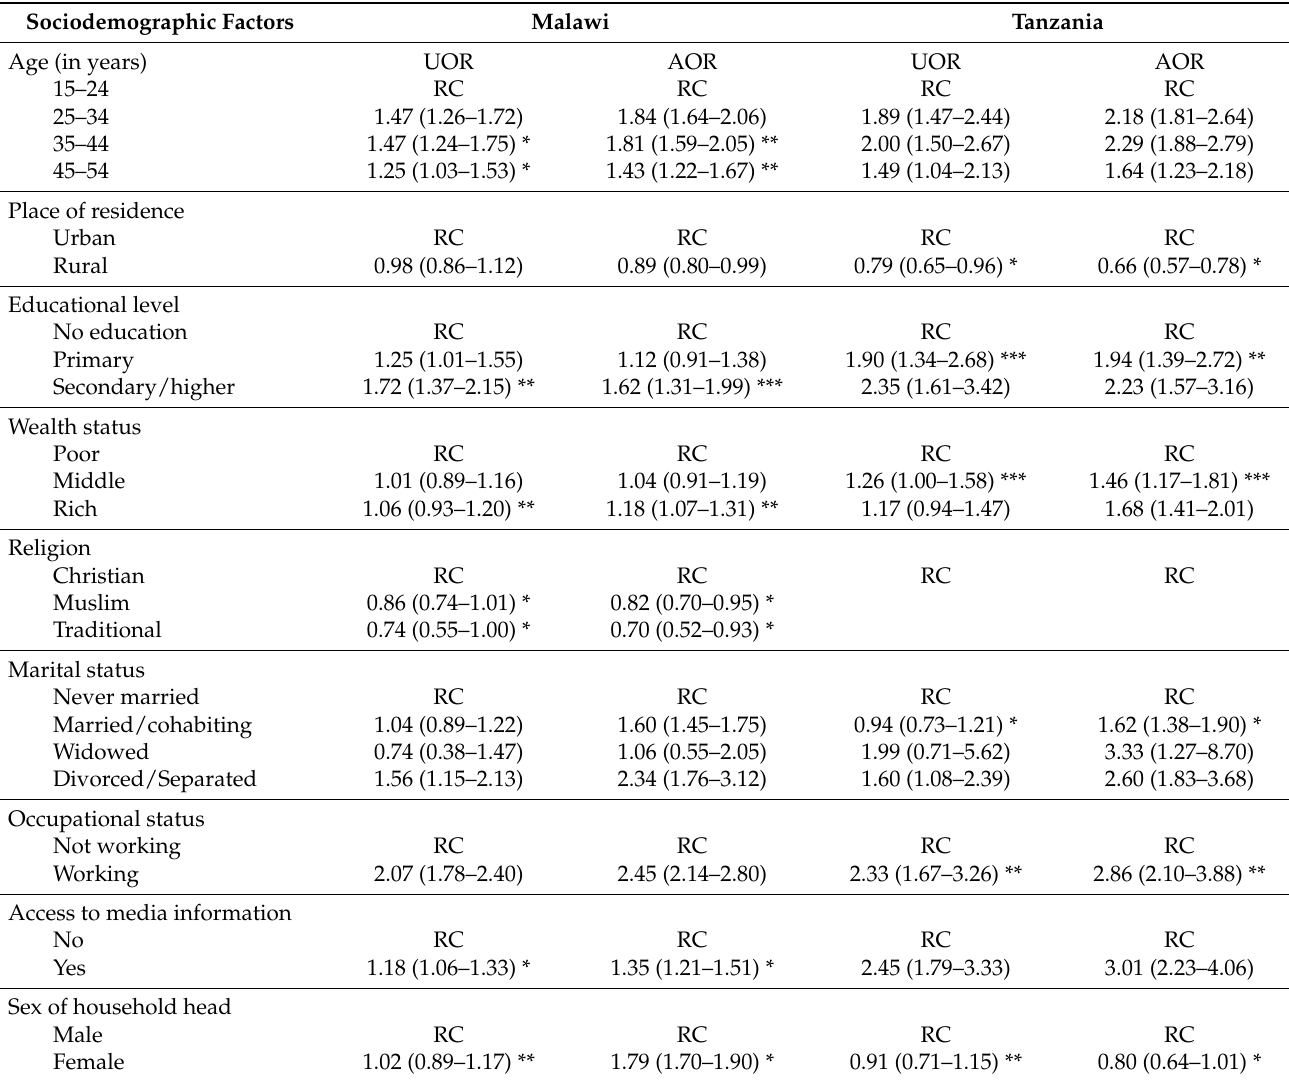
Table 4. Multivariate analysis of male involvement in FP decisions in Tanzania and